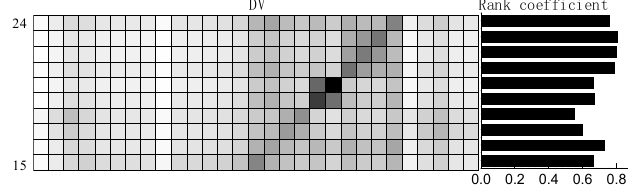
Figure 7. Rank correlation coefficient of DV and SV.